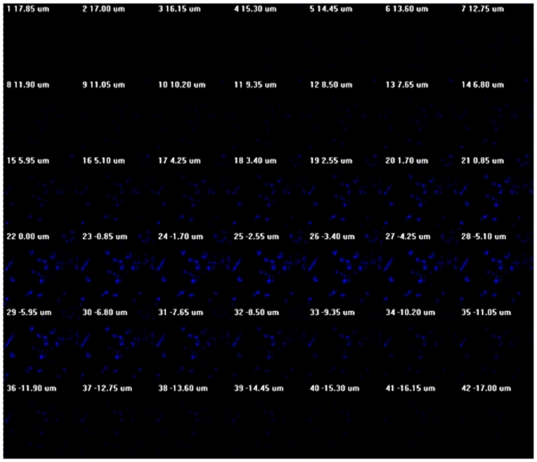
Z-stack of the OF/PCL-b-PEG-NH2 micelles in CP-A cells.